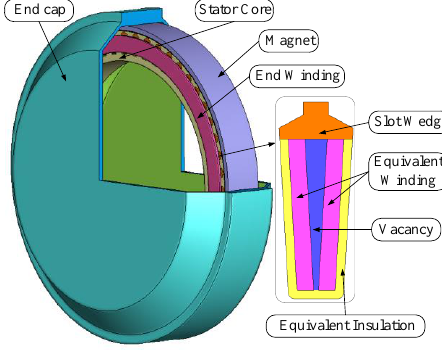
Figure 4. Physical model of the motor.